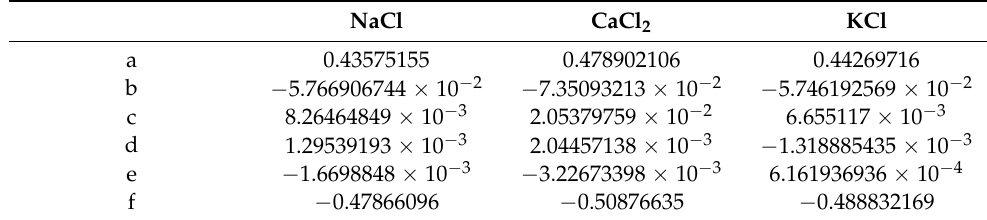
Table 1. Coefficients of the k AQ